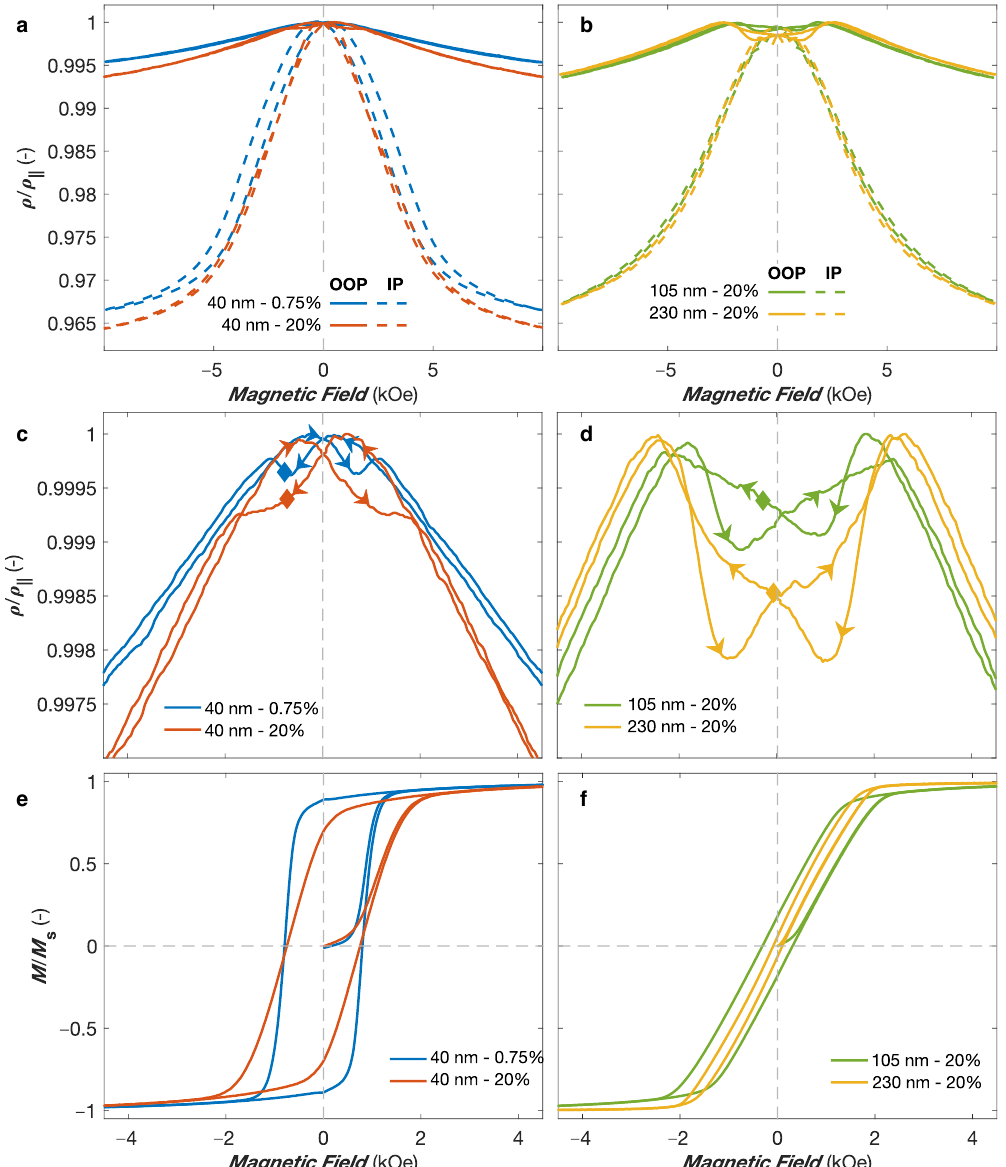
Figure 6. ( a , b ) Room temperature anisotropic magnetoresistance curves measured with the external field applied along the out of the plane (OOP; continuous line) and in the plane (IP; dashed line) directions of interconnected Ni 75 Co 25 nanowire networks with ( a ) 40 nm in diameter and ∼ 0.75% (blue curves) or ∼ 20% (red curves) in packing density, and ( b ) 105 nm (green curves) and 230 nm (orange curves) in diameter and ∼ 20% in packing density. ( c , d ) Close view of the OOP anisotropic magnetoresistance curves in panels ( a , b ) for low magnetic fields. ( e , f ) Room temperature hysteresis loops measured with the external field applied along the OOP direction corresponding to panels ( c , d